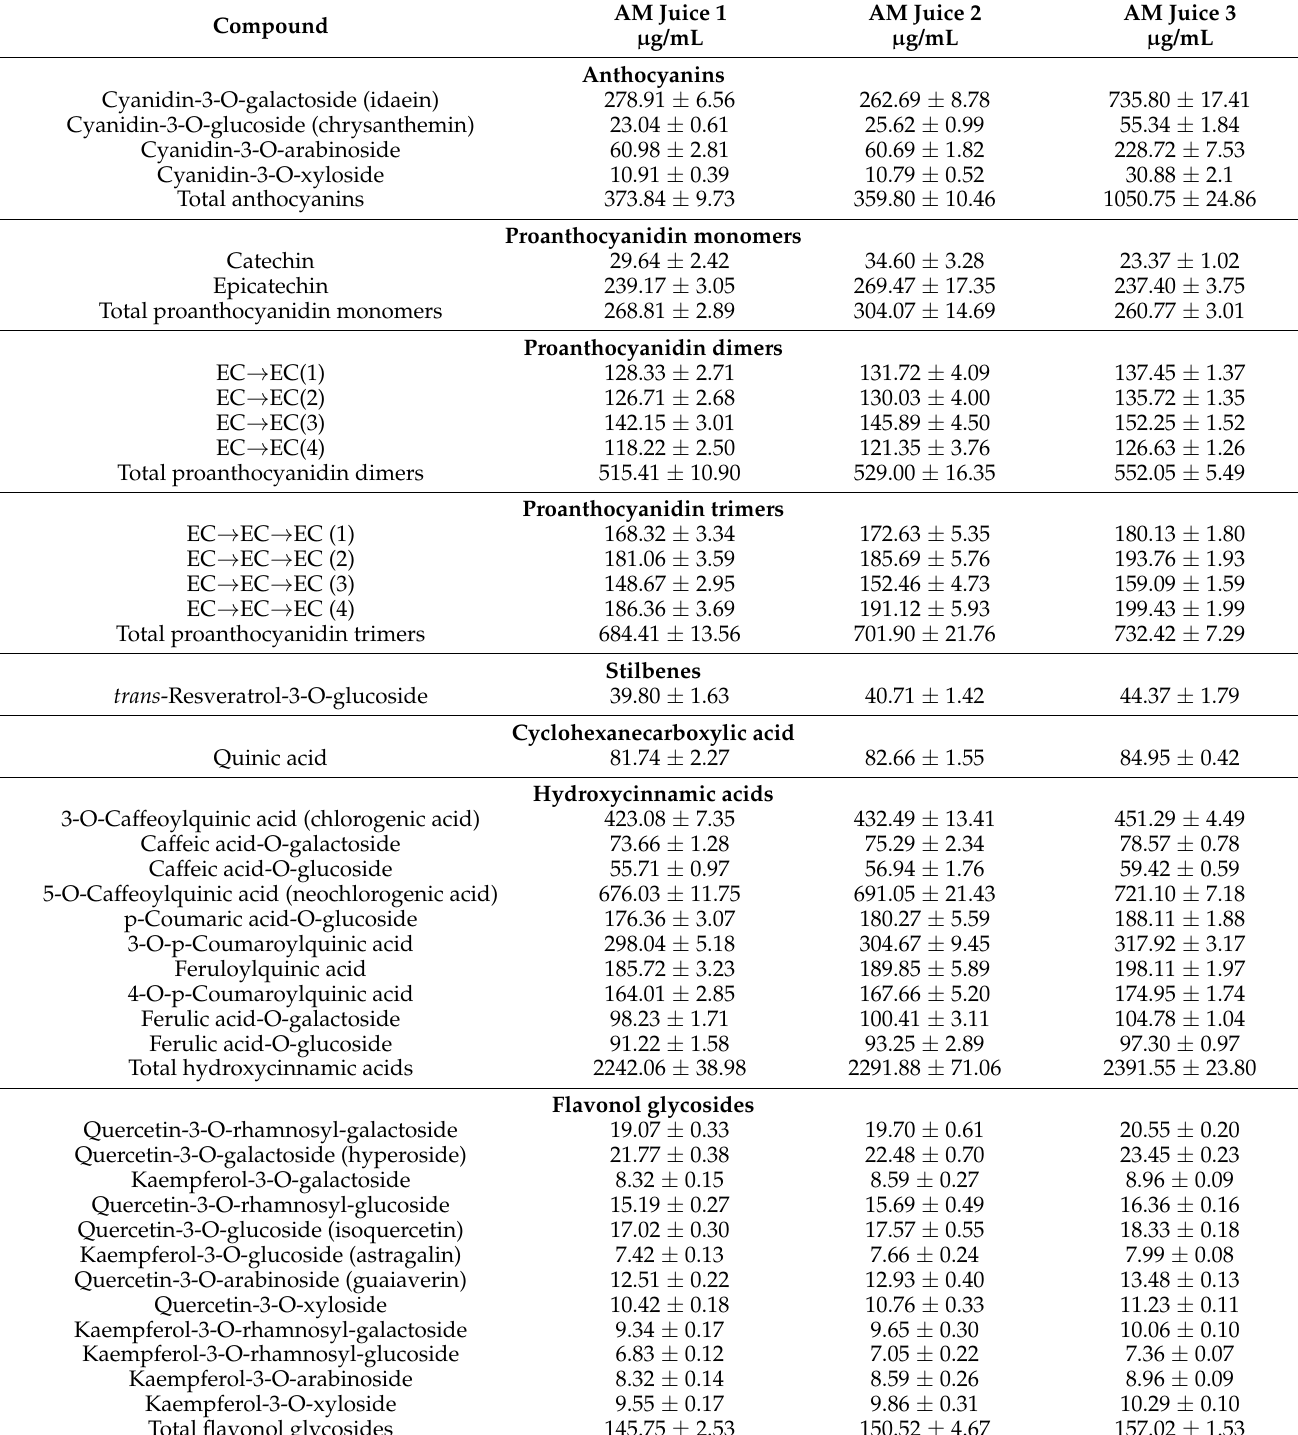
Table 2. Polyphenolics identified in fractions B and C of the SE FAE using LC-PDA-ESI-MS/MS. The concentrations are given in µ g/mL. Results are presented as mean ± standard